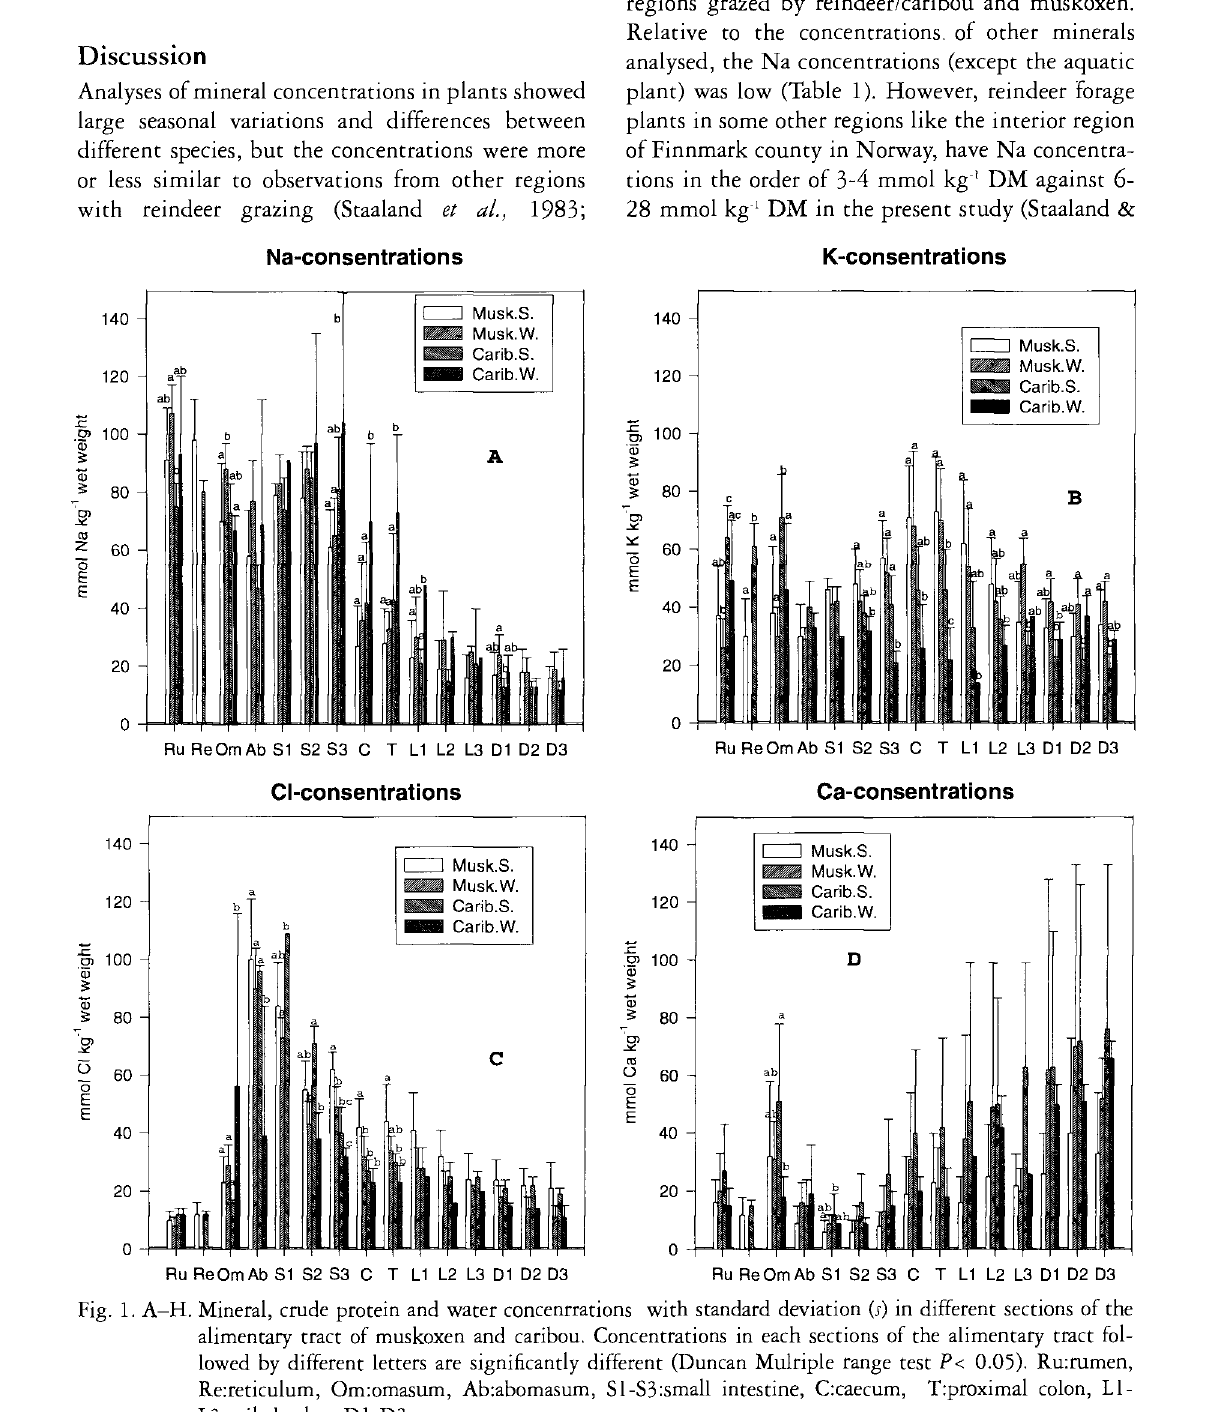
Fig. 1. A - H. Mineral, crude protein and water concenrrations with standard deviation (s) in different sections of the alimentary tract of muskoxen and caribou. Concentrations in each sections of the alimentary tract fol lowed by different letters are significantly different (Duncan Mulriple range test P< 0.05).